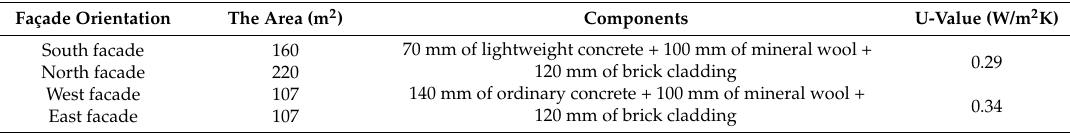
Table 2. Building envelope characteristics: exterior walls.